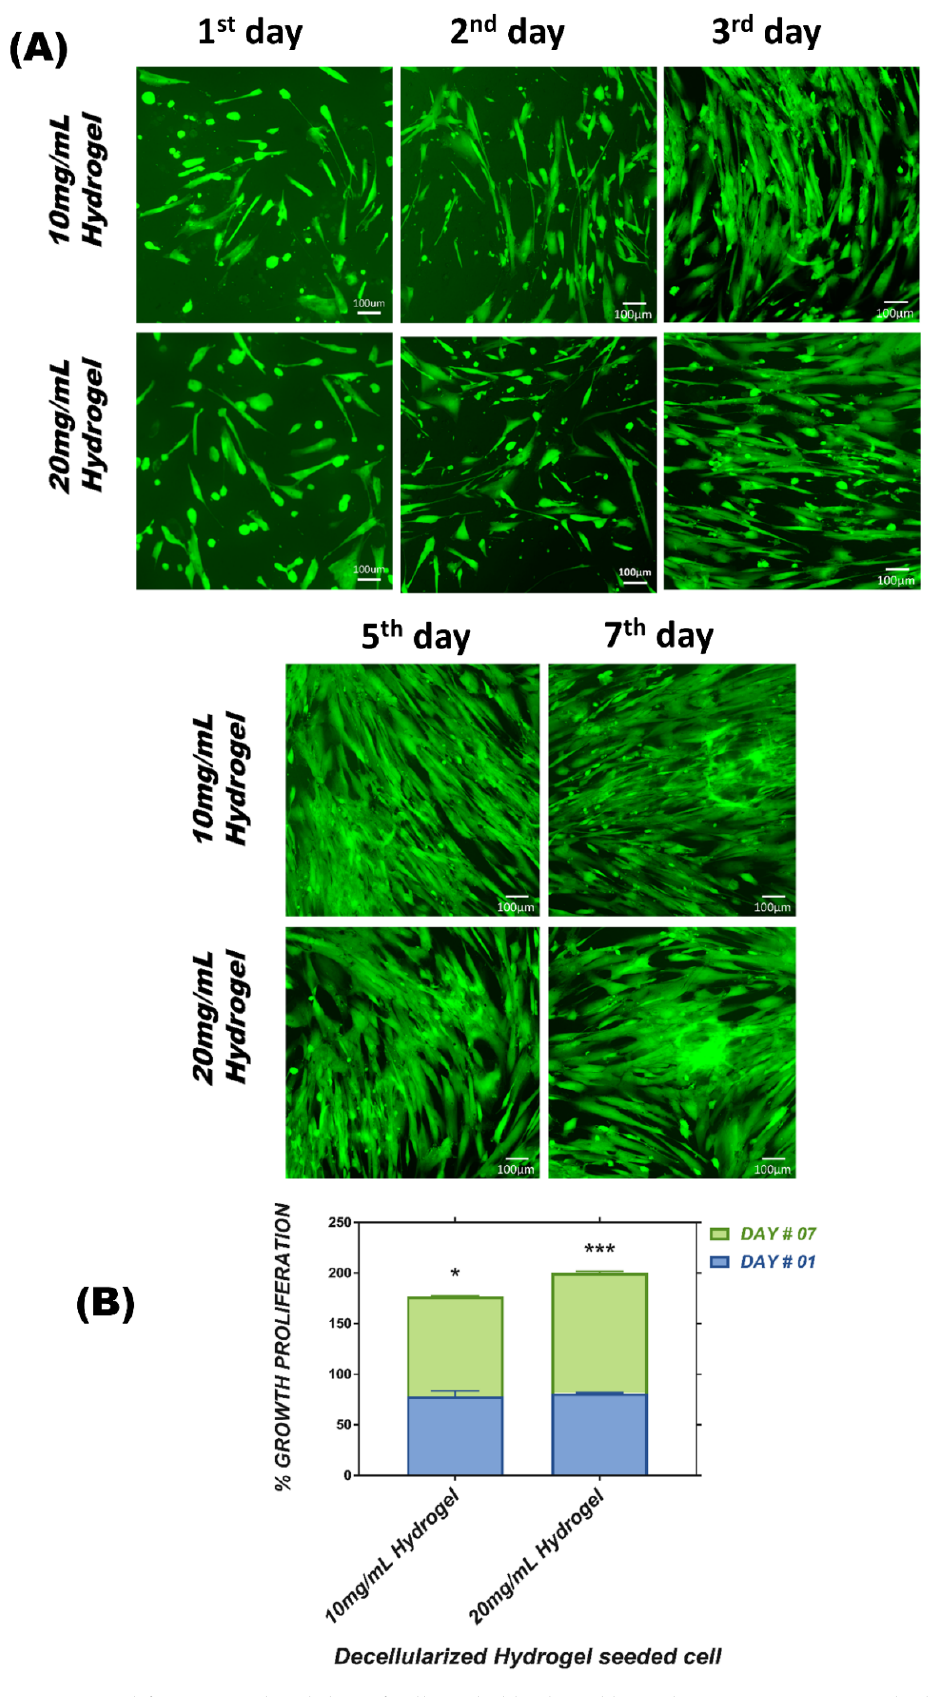
Figure 6. Proliferation and viability of cell-seeded hydrogel by Calcein-AM staining and Alamar blue assay: ( A ) Fluorescent microscopic images of DUC hydrogel, showing proliferation/